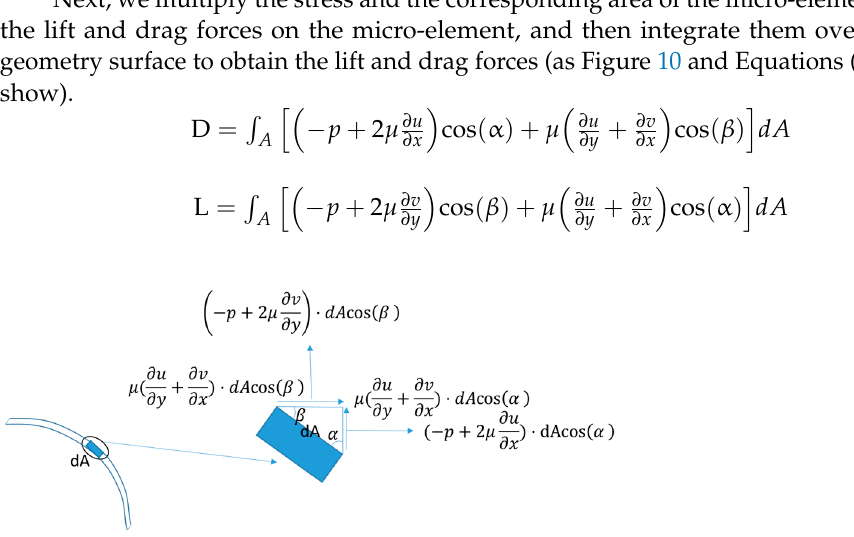
Figure 9. The total stress on the micro-element, including two normal stresses as well as two iden- tical tangential stresses.